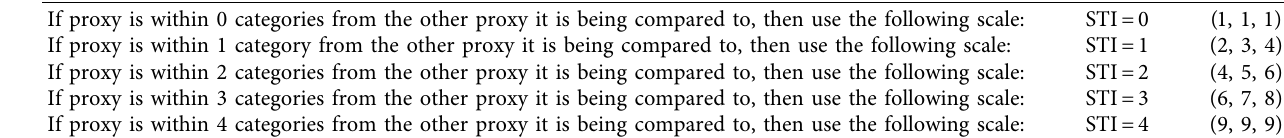
Table 9: Steps to ideal (STI) scale and the corresponding triangular fuzzy scale.